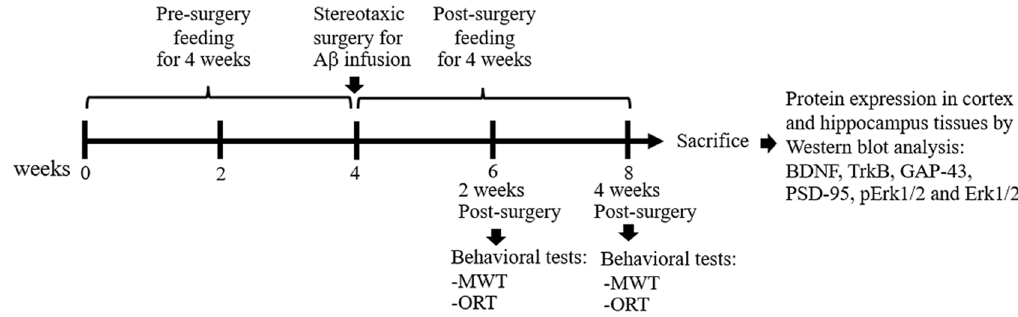
Figure 1. Sequence of the study procedure.